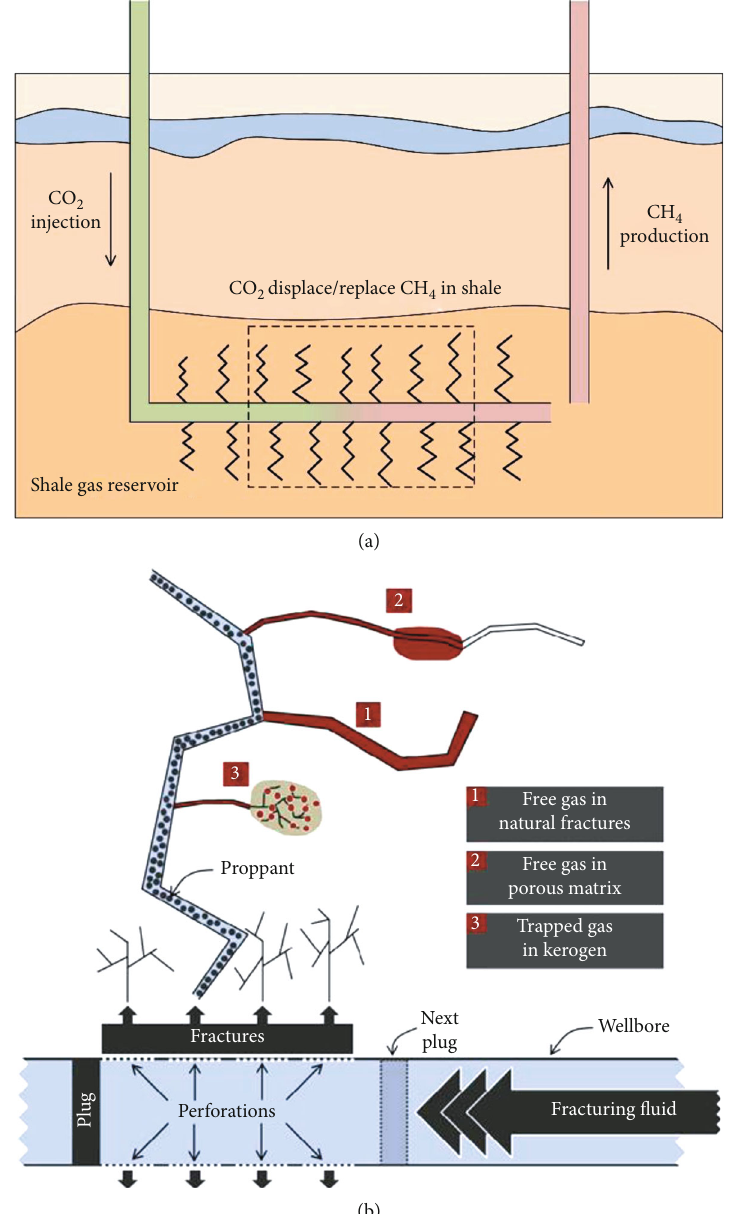
Figure 1: (a) Schematic diagram of CO fracturing for enhanced shale gas recovery CO 2